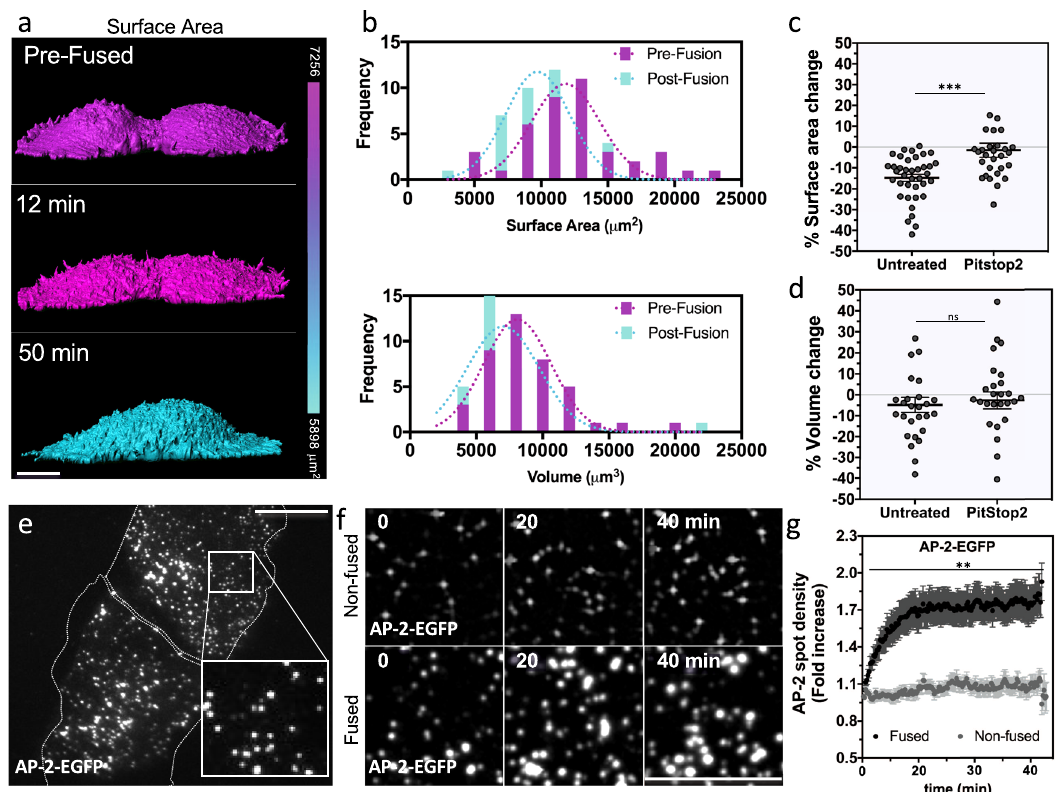
Fig. 4 Remodeling upon cell fusion reduces the plasma membrane surface area by increasing endocytosis. a SUM-159 cells expressing VSV-G and a PM marker (CAAX- EGFP) were imaged by confocal microscopy as cells fused (Z-stacks were used to generate three-dimensional models of cells). The surface of fusing cells is colored based on the surface area as measured by the IMARIS surface tool (see also Supplementary Movie 6). b The frequency distribution of surface area and volume of pairs of cells within 30 min of cell fusion are shown. The percentage change in plasma membrane surface area ( c ) and cell volume ( d ) 30 min after cell fusion with or without PitStop2 treatment to inhibit endocytosis are graphed. Error bars represent the SEM, n = 38 and n = 29 cells examined over three independent experiments for untreated and PitStop2 treated cells, respectively. *** p = 0.0004. e , f CRISPR-Cas9 gene edited SUM-159 cells expressing endogenous AP-2 – EGFP and transfected with VSV-G, were induce to fused, and the density of AP-2 – EGFP at the plasma membrane was measured overtime by TIRF microscopy (using 100 μ m 2 cropped images, such as the inset in e ). Representative images of AP-2 – EGFP puncta at the indicated time points in non-fusing ( f , upper) and fusing cells ( f , lower). g The fold increase in AP-2 – EGFP puncta density was measured every 16.5s for about 1h. The differences in AP2-EGFP density between non-fused and fused cells became statistically different 2 min after cell fusion began (see also Supplementary Movie 7). Error bars represent the SEM, n = 13 and n = 41 for non-fused and fused cells, respectively. From 2 to 44min, * p < 0.03. ns not signi fi cant ( p > 0.05). Statistical signi fi cance calculations were performed using a two-tailed unpaired Student ’ s t test. Scale bar size = 10 μ